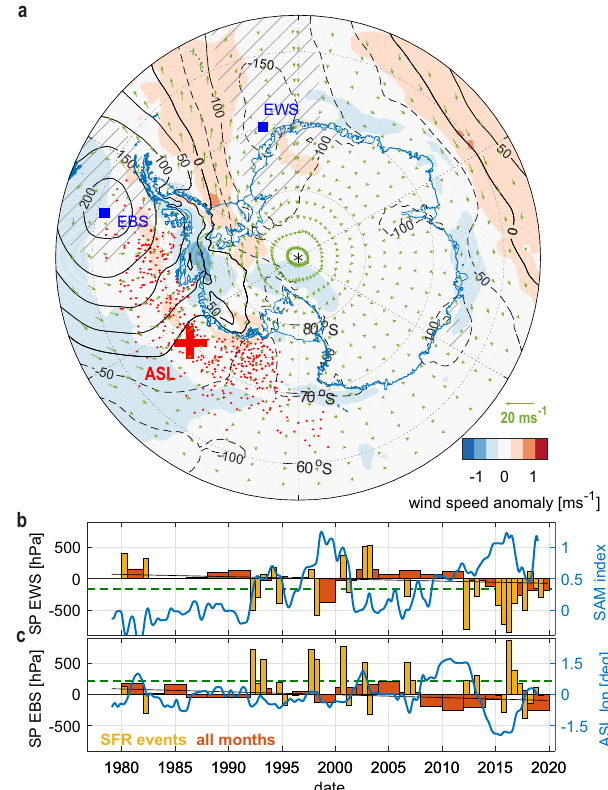
Fig. 5 Atmospheric conditions associated with enhanced sea ice formation. a Composite of atmospheric anomalies in surface pressure (SP in Pa, above 99% con fi dence level in hatched areas), wind vectors (arrows), and speed (color) associated with enhanced SFR events shown in Fig. 1d; red dots: monthly locations of the Amundsen Sea low since 1979 scattered around the time mean position indicated by the red cross. b Time series of SP anomalies located at the blue square in the eastern Weddell Sea (EWS), and ( c ) the Eastern Bellingshausen Sea (EBS), averaged for all months (only months associated with enhanced SFR events) in 2 years (6 months) bins. Green dashed lines indicate the average for all enhanced SFR events, black lines show the linear trend over all months. Blue curves show the 36-month low-pass fi ltered evolution of the large-scale indicators associated with favorable negative (positive) SP anomalies at EWS (EBS) that lead to enhanced southerly (offshore) winds at the Ronne Ice Shelf front. Negative ASL longitude anomalies indicate westward displacements that favor high pressure anomalies in the